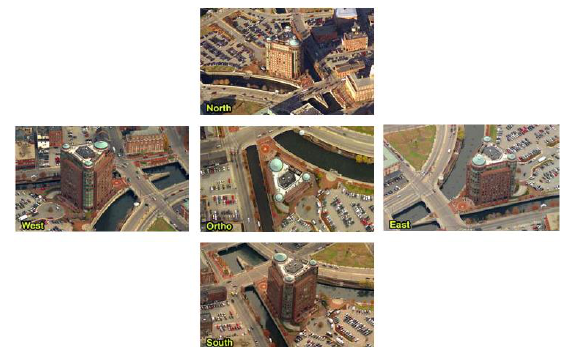
Figure 4. Five views of a building (Nelson, 2008)